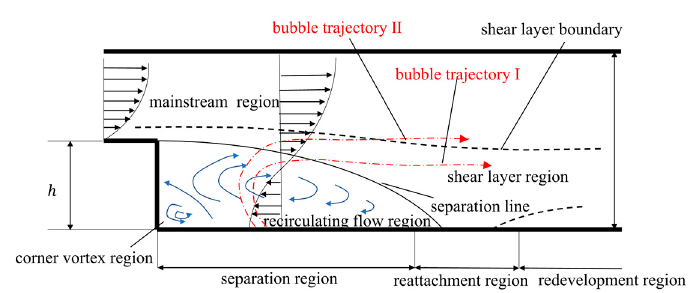
Figure 22. Typical flow structure of backward-facing step flow.